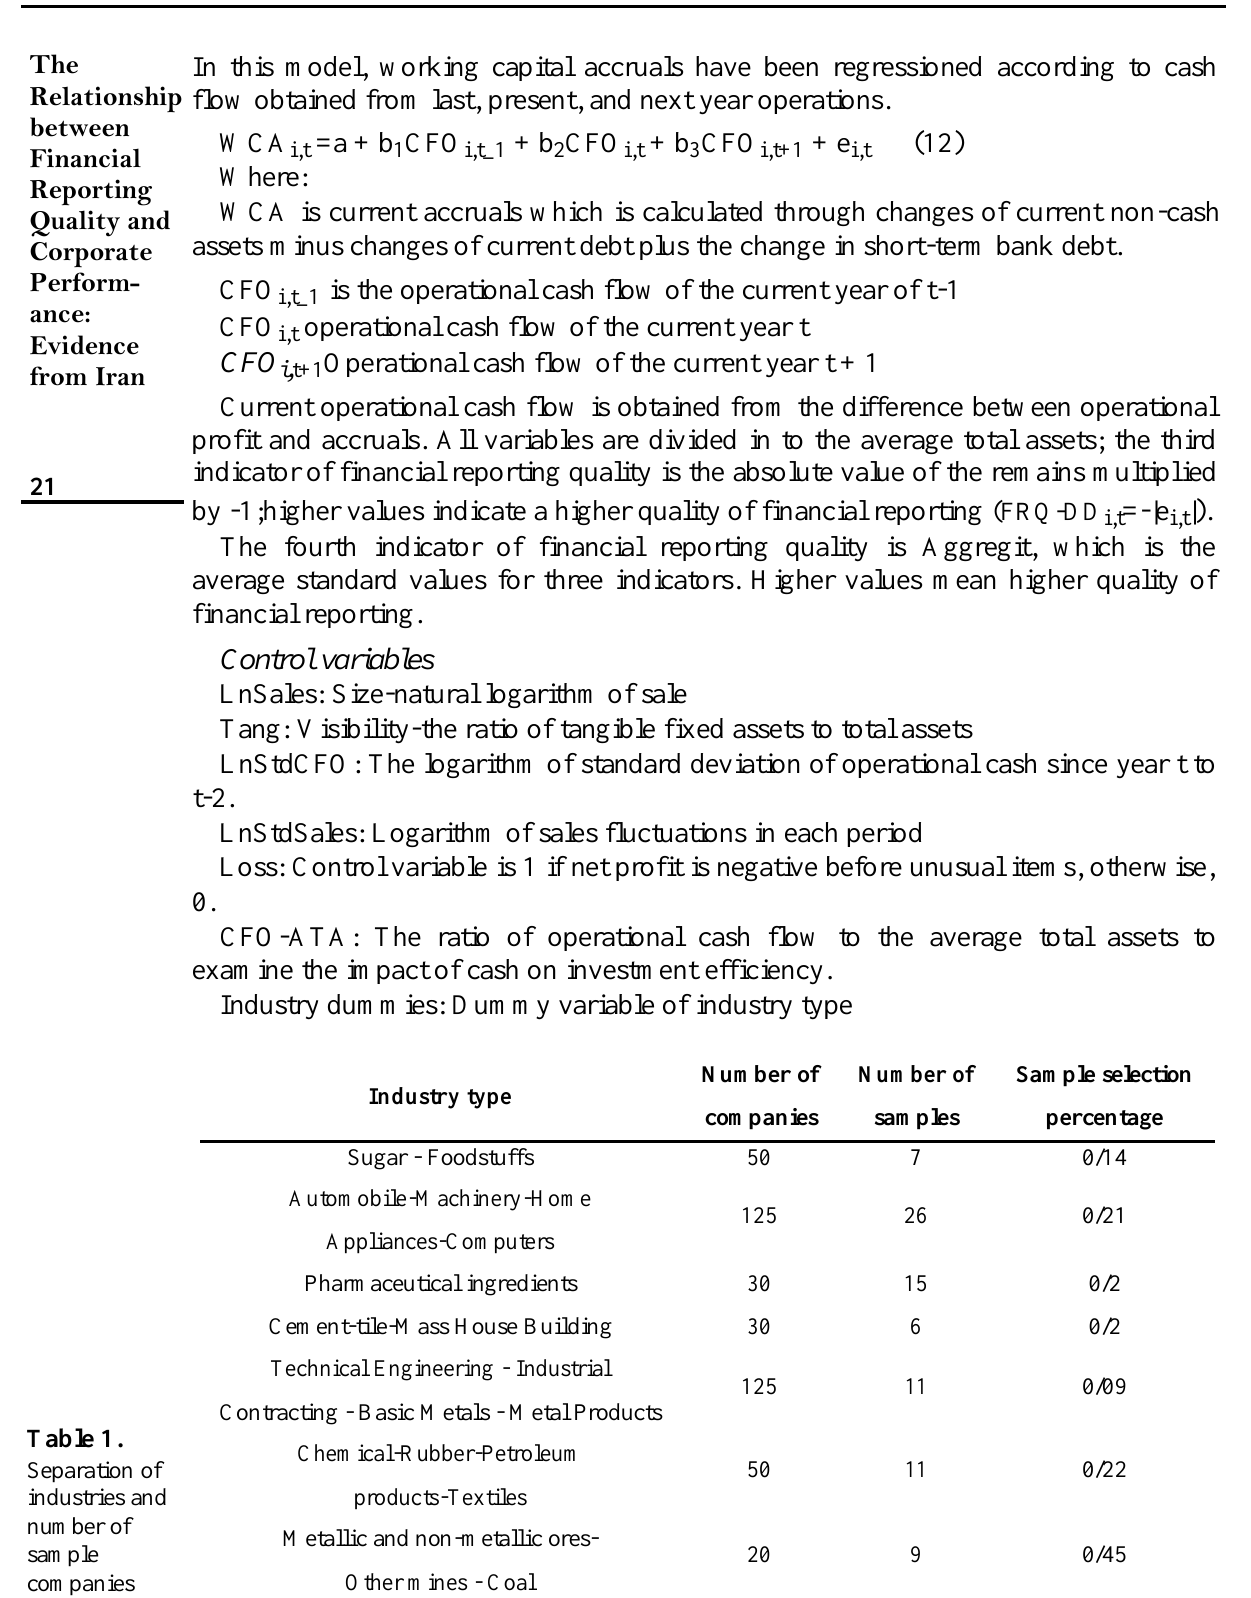
Separation of industries and products-Textiles